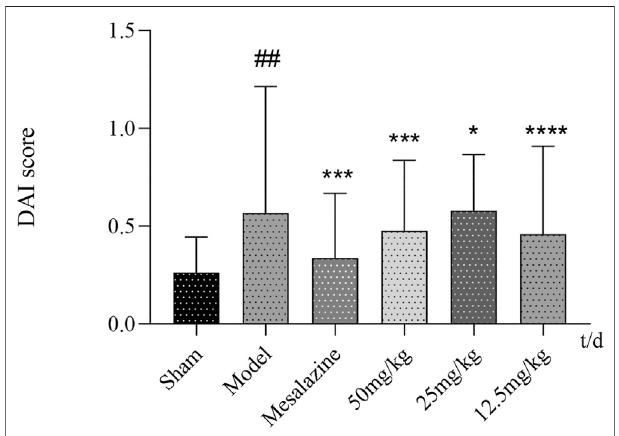
FIGURE 5 | DAI score curve of mice in each group. # p < 0.05 vs. control group and * p < 0.05 vs. model group.